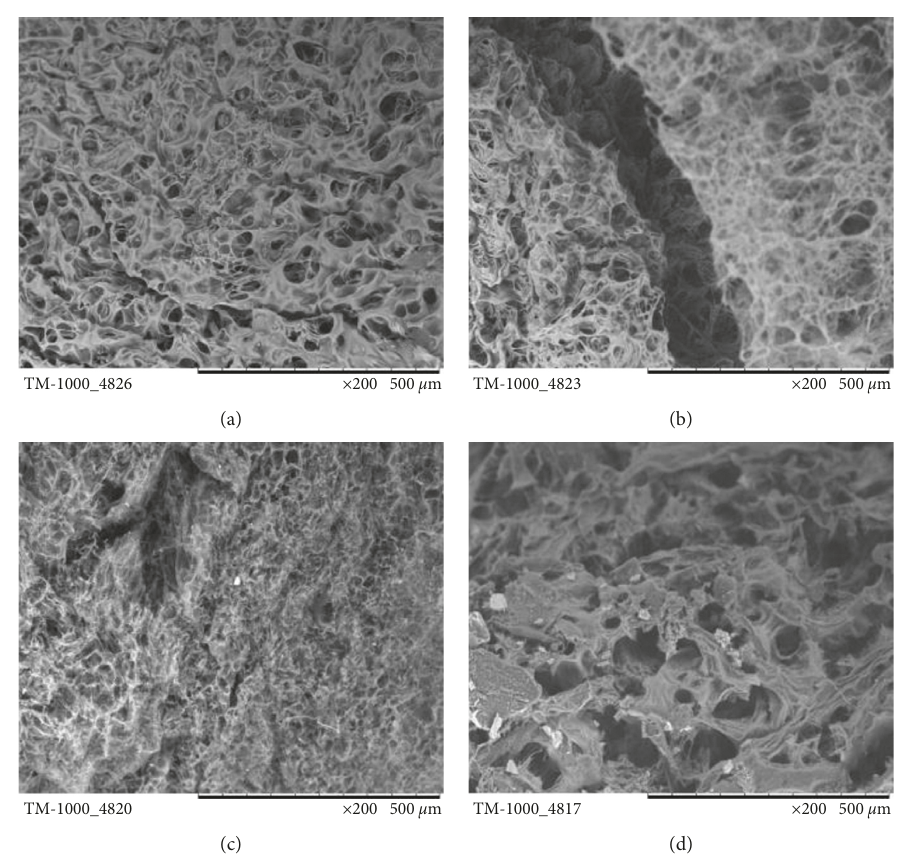
Figure 2: SEM images for hydrogels made from CMC 2%: (a) ionotropic gelation with CaCl 4.9% w/v; (c) polyelectrolyte complexation with CS 0.01% w/v; (d) combination of ionotropic gelation and polyelectrolyte complexation (CaCl 2 1% w/w). Scale 200x.